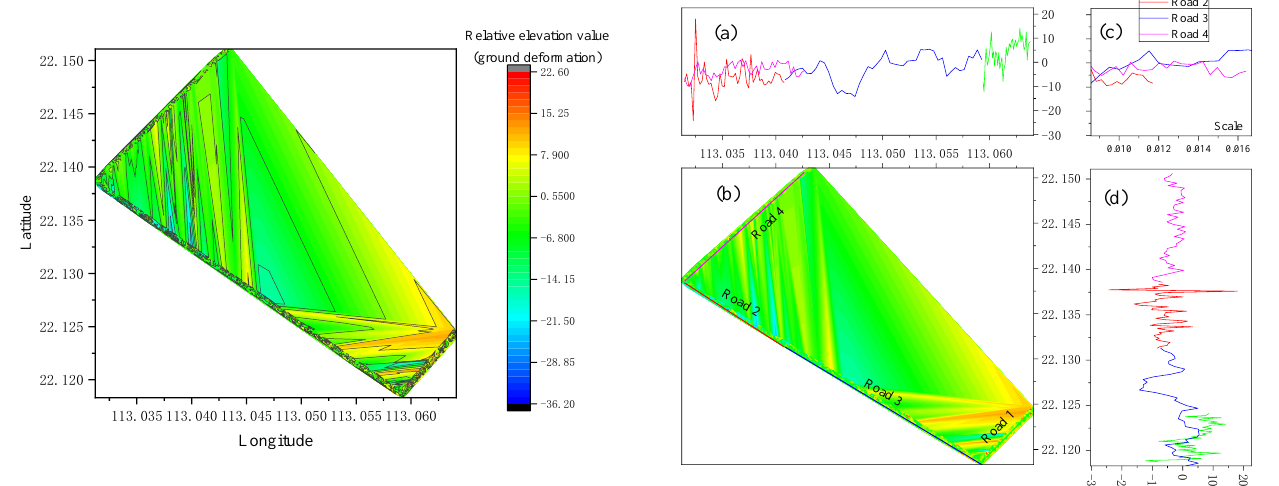
Figure 23. DEM and DEM profile of the surrounding roads in the Mud receiving area after interpo lation optimization. ( a , c ) show the profile of the DEM in both latitude and longitude, ( b ) shows the DEM of the area, and ( d ) shows the scales of different roads.